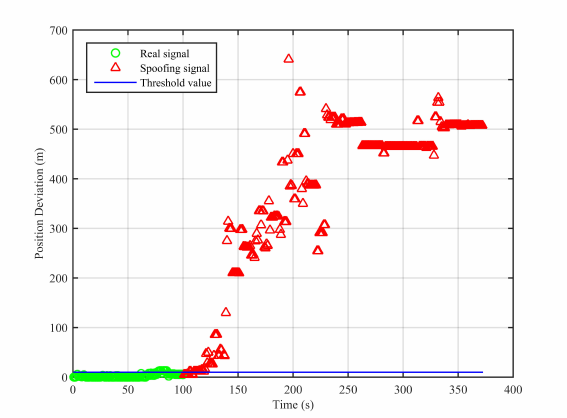
Figure 10. Position deviations of the two algorithms (dynamic position spoofing